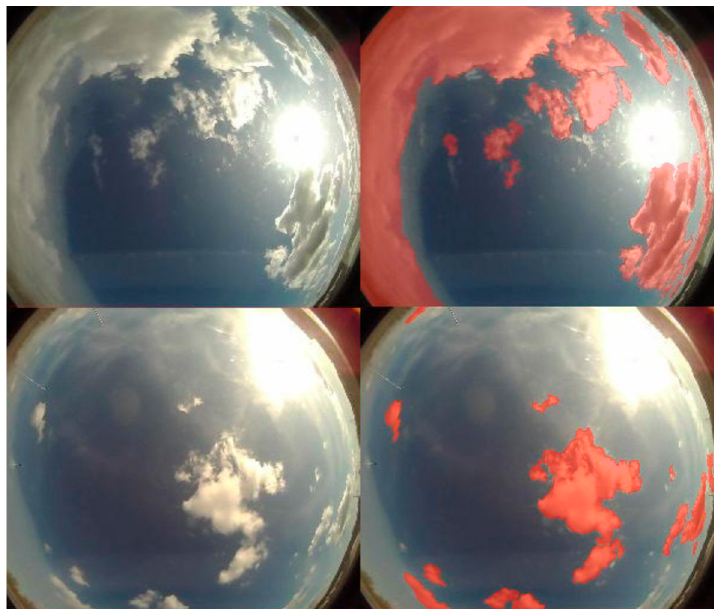
Figure 10. Visualization of the CloudSegNet network using the evaluation data set (left side—input image, right side—segmentation mask).